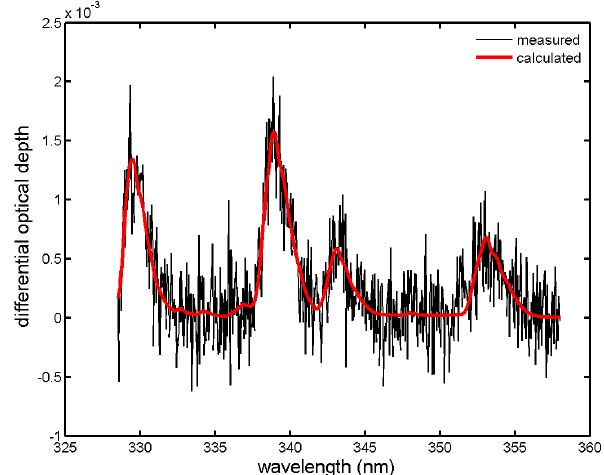
Figure 2. Example of HCHO DOAS fit at ISSJ. It corresponds to 22 August 2010 (the same date as the FTIR fit example presented in Fig. 1) at 16:30UTC and 0 ◦